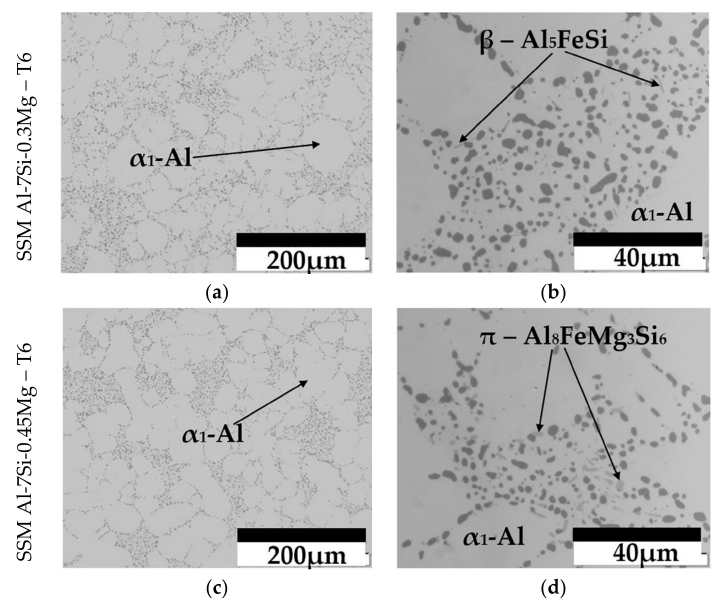
Figure 9. Micrographs of the di ff erent SSM castings: ( a , b ) SSM Al-7Si-0.3Mg—T6, ( c , d ) SSM Al-7Si-0.45Mg—T6. Light grey: iron-rich intermetallics. Dark grey: eutectic silicon.